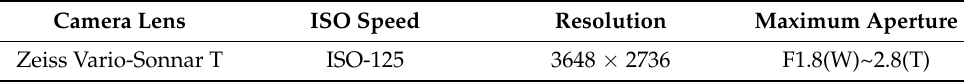
Table 1. Sony DSC-RX100M4 camera.